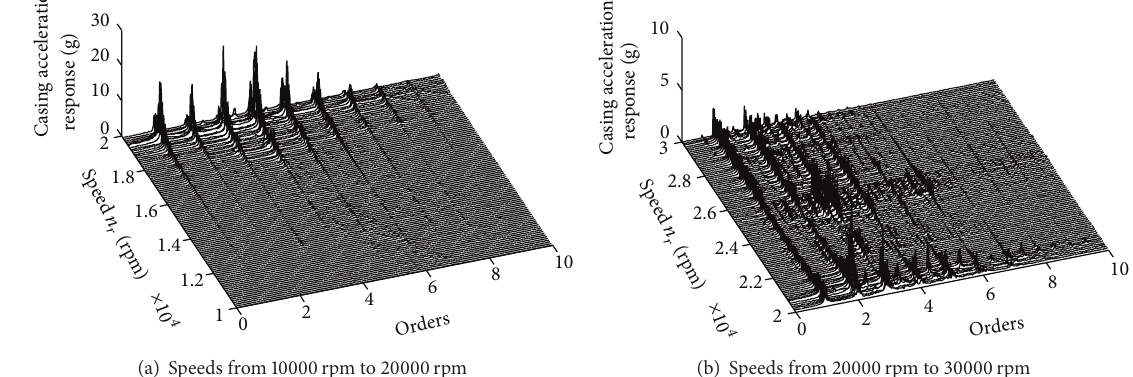
Figure 7: Cascade plot of the casing acceleration response at different